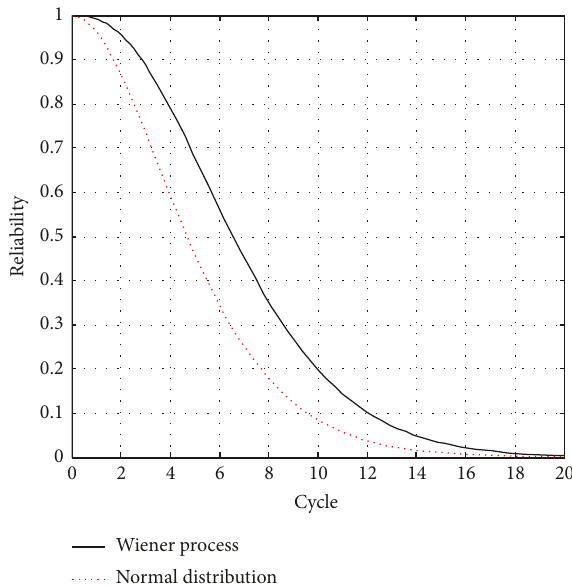
Figure 8: The curve of system reliability R ( t ) .